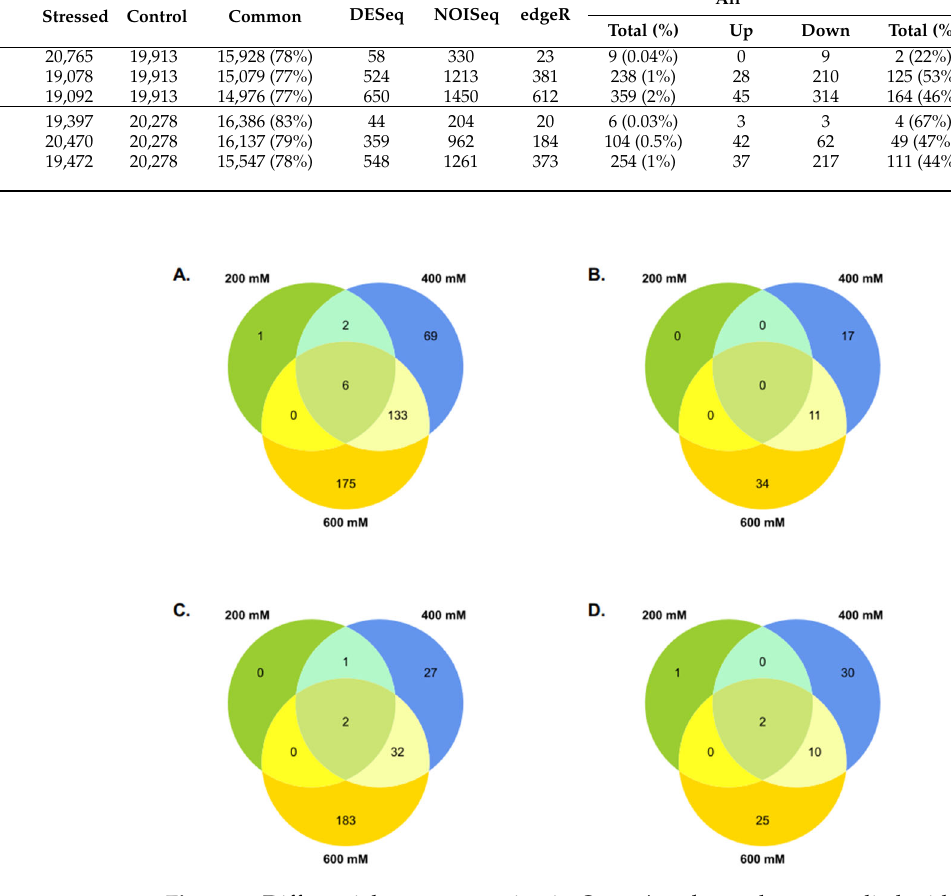
Figure 2. Differential gene expression in Casuarina glauca plants supplied with KNO 3 (KNO 3+ ) or nodulated by nitrogen-fixing Frankia casuarinae Thr (NOD + ), grown at 200 mM, 400 mM, and 600 mM NaCl. Total number of treatment-specific differentially expressed genes (DEGs) for each salt treatment relative to the control (0 mM NaCl). 200: 200 vs. 0 mM NaCl; 400: 400 vs. 0 mM NaCl; and 600: 600 vs. 0 mM NaCl. ( A ) KNO 3+ downregulated DEGs. ( B ) KNO 3+ upregulated DEGs. ( C ) NOD + downregulated DEGs. ( D ) NOD + upregulated DEGs.